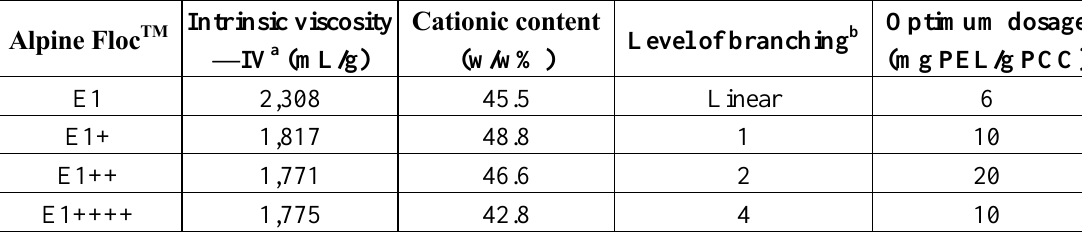
Table 1. Flocculants characteristics and optimum flocculant dosage for precipitated calcium carbonate (PCC)